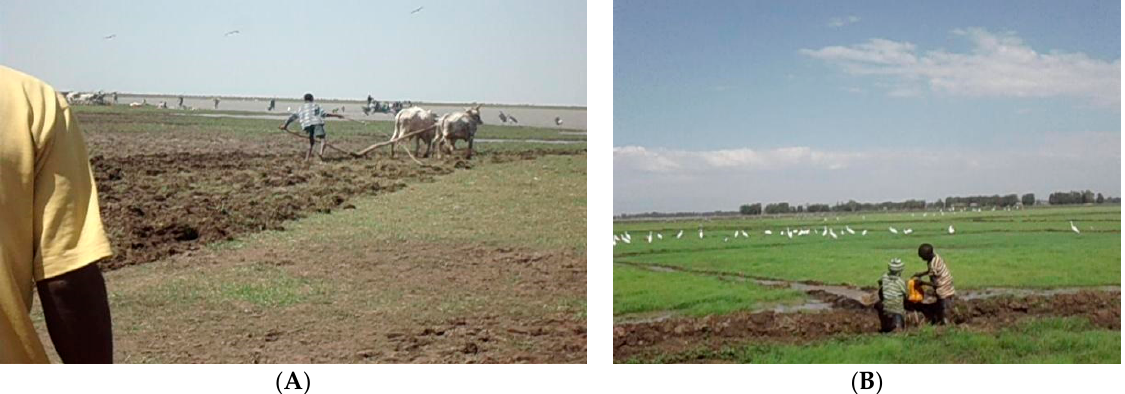
Figure 6. Flood recession farming ( A ) and small-scale irrigation ( B ) near Lake Tana and